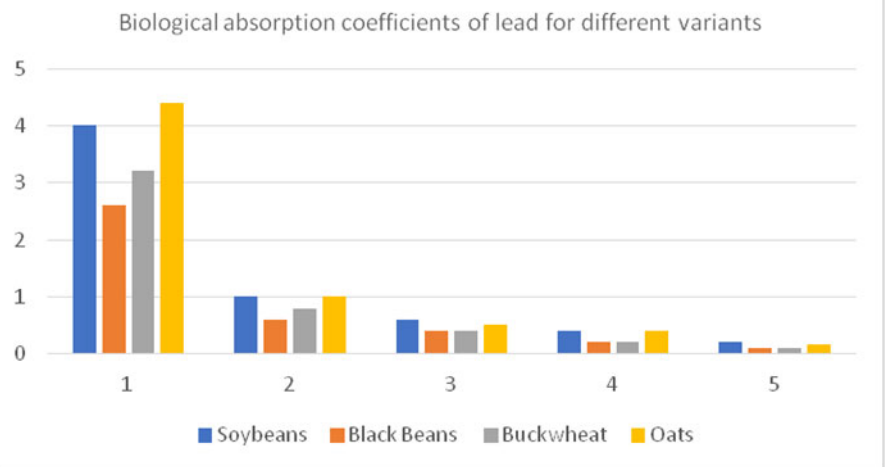
Figure 10. Values of coefficients of biological absorption A х (2) of copper at the different variants of the experiments (different total pollution index Zc).